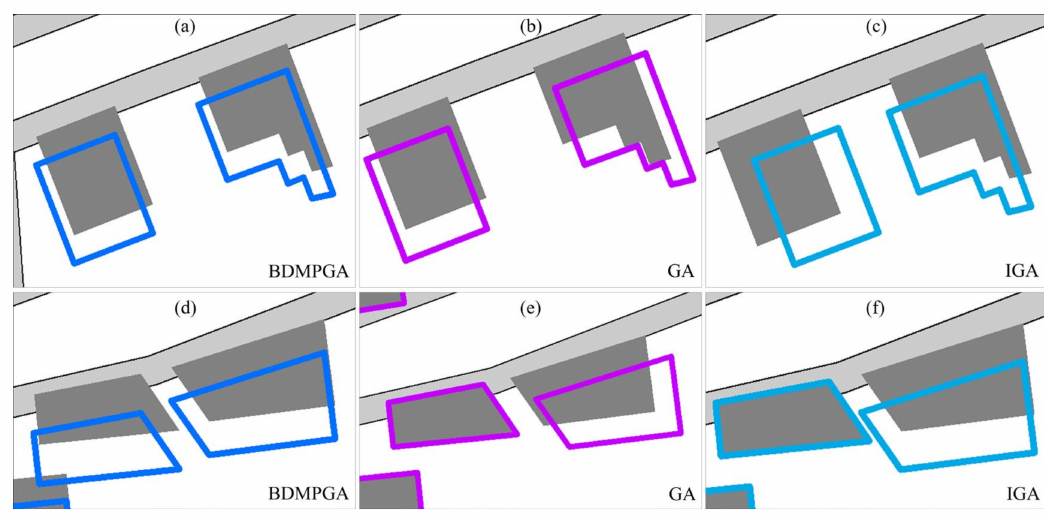
Figure 8. Contrast in detail using the proposed BDMPGA and the other two methods. ( a – c ) Results of maintaining the relative position between buildings of local region 1 using the BDMPGA, GA and IGA, respectively; ( d – f ) Results of maintaining the relative position between buildings of local region 2 using the BDMPGA, GA and IGA,